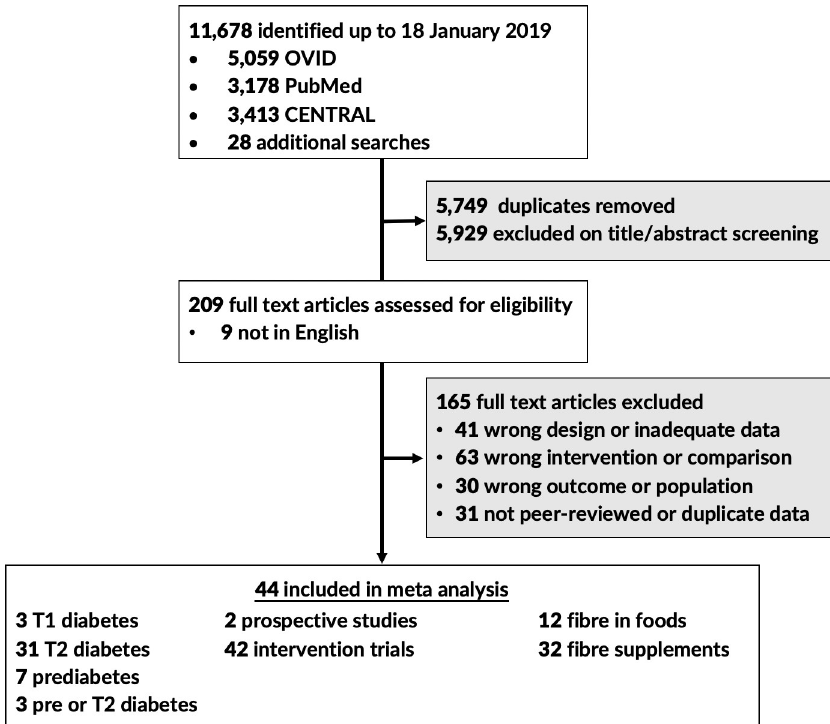
Fig 1. Flow chart indicating the process by which eligible prospective cohort studies and controlled trials were